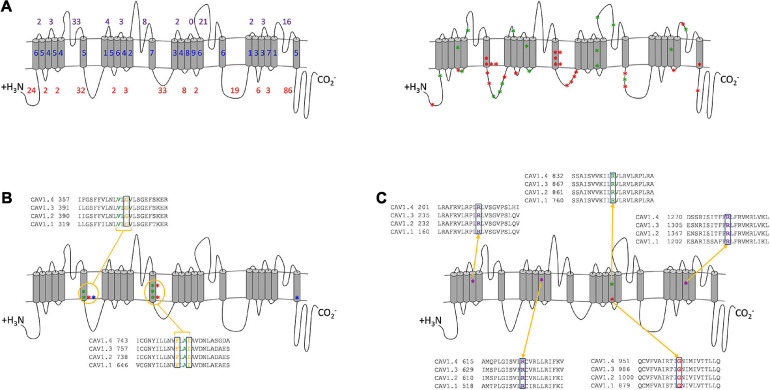
Combined analysis of Cav1 mutation positions. (A) Location of Cav1 α1 subunit mutations. (Left) The number of mutations in transmembrane (blue), extracellular (purple) and cytoplasmic (red) regions. (Right) The 47 functionally tested missense mutations are shown as red (GoF) and green (LoF) stars. Stars represent a mutated residue and may include multiple amino acid substitution. The cytoplasmic loops are the most frequently mutated regions (222 mutations), of which, 86 are in the C-terminal tail, whereas the extracellular loops have 97 mutations, and the transmembrane domains have 110 mutations. 114 mutations are in the pore-forming domains, and 25 are in the S4 VSDs. (B) Three functionally characterized hypermorphs in S6 repeats I and II of Cav1.4 [p.Gly369Asp (Hoda et al., 2005), p.Phe753Cys (Hope et al., 2005), p.Ile756Thr (Peloquin et al., 2007)] (red) are present at the equivalent position in Cav1.2: p.Gly402Ser (Splawski et al., 2005) (equivalent to p.Gly369Asp) (blue) and Cav1.3: p.Gly403Asp/Arg (Scholl et al., 2013) (equivalent to p.Gly369Asp), p.Ile750Met (Scholl et al., 2013) (equivalent to p.Ile756Thr), p.Phe747Leu (Pinggera et al., 2018) (equivalent to p.Phe753Cys) (green). (C) Five mutations to the VSDs (four hypomorphs and one null) are functionally analyzed mutants that damage the sensor’s voltage sensitivity and reduce the channel’s conductance in Cav1.1 [p.Arg174Trp (Bannister and Beam, 2013), p.Arg528His (Morrill et al., 1998), p.Arg1239His/Gly (Morrill and Cannon, 1999)] (purple), Cav1.3 [p.Arg990His (Monteleone et al., 2017)] (green), and Cav1.4 [p.Gly1007Arg (Peloquin et al., 2007)] (red). The conservation in paralogs is shown for each residue.